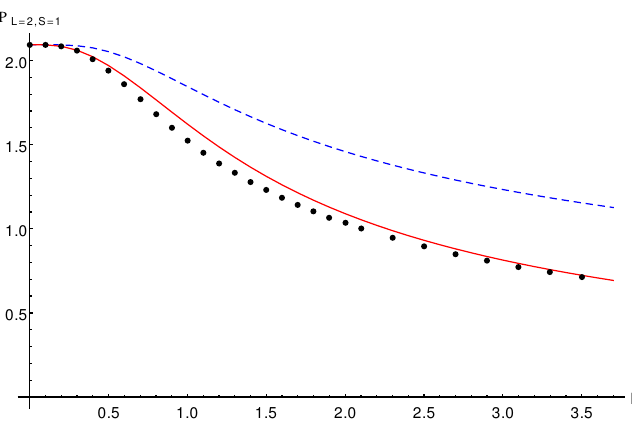
Figure 10 . Plot of P L =2 ;S =1 as a function of h : the dots correspond to the exact numerical data, the solid line interpolates the values of P ABA calculated by (5.19) and (5.18)